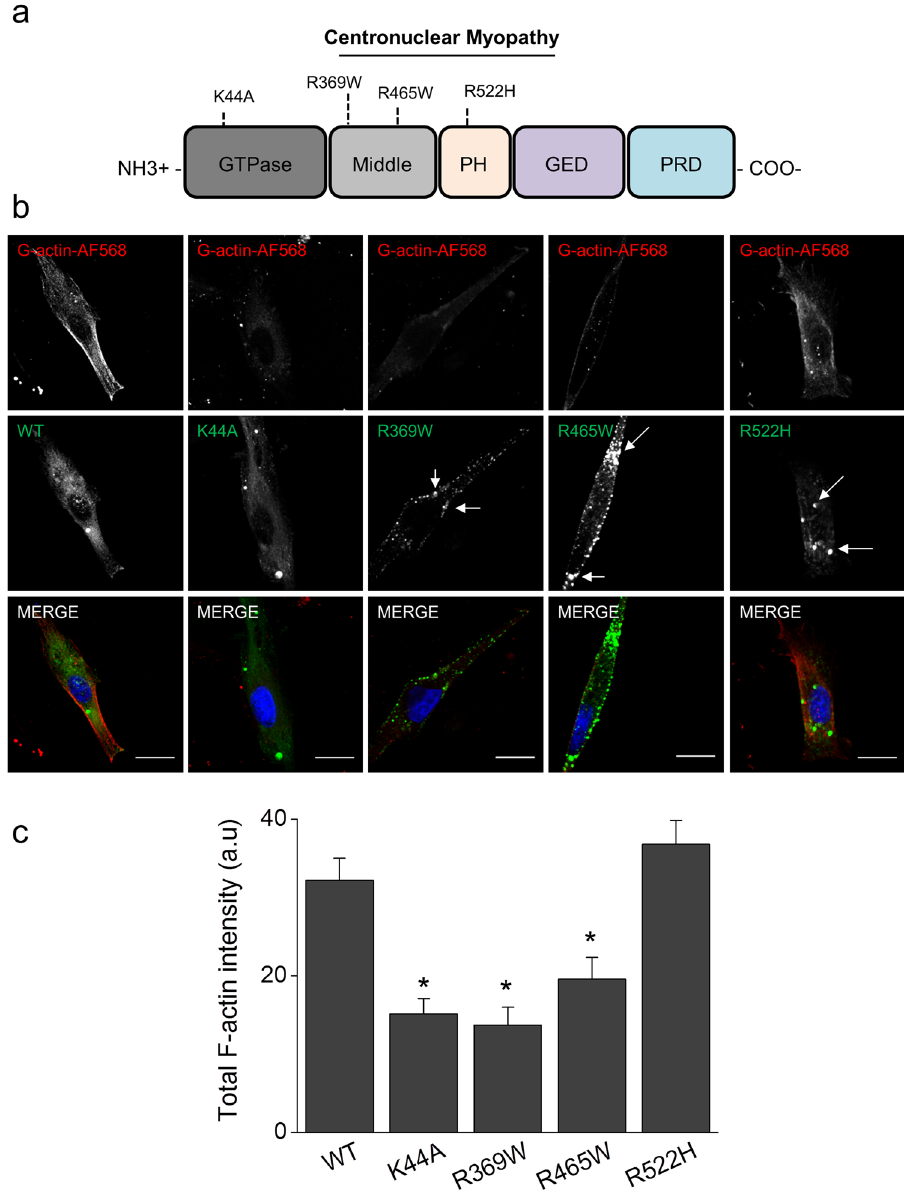
Figure 3. CNM-associated mutations in dynamin-2 reduce de novo actin filament formation in RCMH myoblasts. RCMH myoblasts were transfected by lipofection with EGFP-fused constructs expressing dynamin-2 WT, the GTP-ase defective mutant K44A, the middle domain mutants R369W or R465W or the PH domain mutant R522H. 48 h later, transfected cells were permeabilized with digitonin in the presence of G-actin-AF568, fixed and visualized by confocal microscopy. ( a ) The diagram indicates the location of the currently studied mutations. ( b ) Representative confocal images of the newly formed actin filaments (top panels) in RCMH myoblasts expressing Dyn2WT, K44A, R369W, R465W or R522H (middle panels). Note that CNM-mutants form dynamin-2 aggregates in the cytosol of RCMH cells (white arrows). Scale bar = 10 µ m. ( c ) Quantification of the total intensity fluorescence of the recently formed actin. Note that, compared with WT, the expression of the mutants K44A, R369W and R465W, but not of R522H, significantly inhibits the new formation of actin filaments. Data are expressed as mean actin fluorescence intensity ± SEM. Statistical comparisons were performed utilizing a two-tail t-test Welch corrected for parametric data; * p < 0.0001 compared to Dyn2WT- transfected cells. N is between 24 and 34 cells, from at least three different cultures per experimental